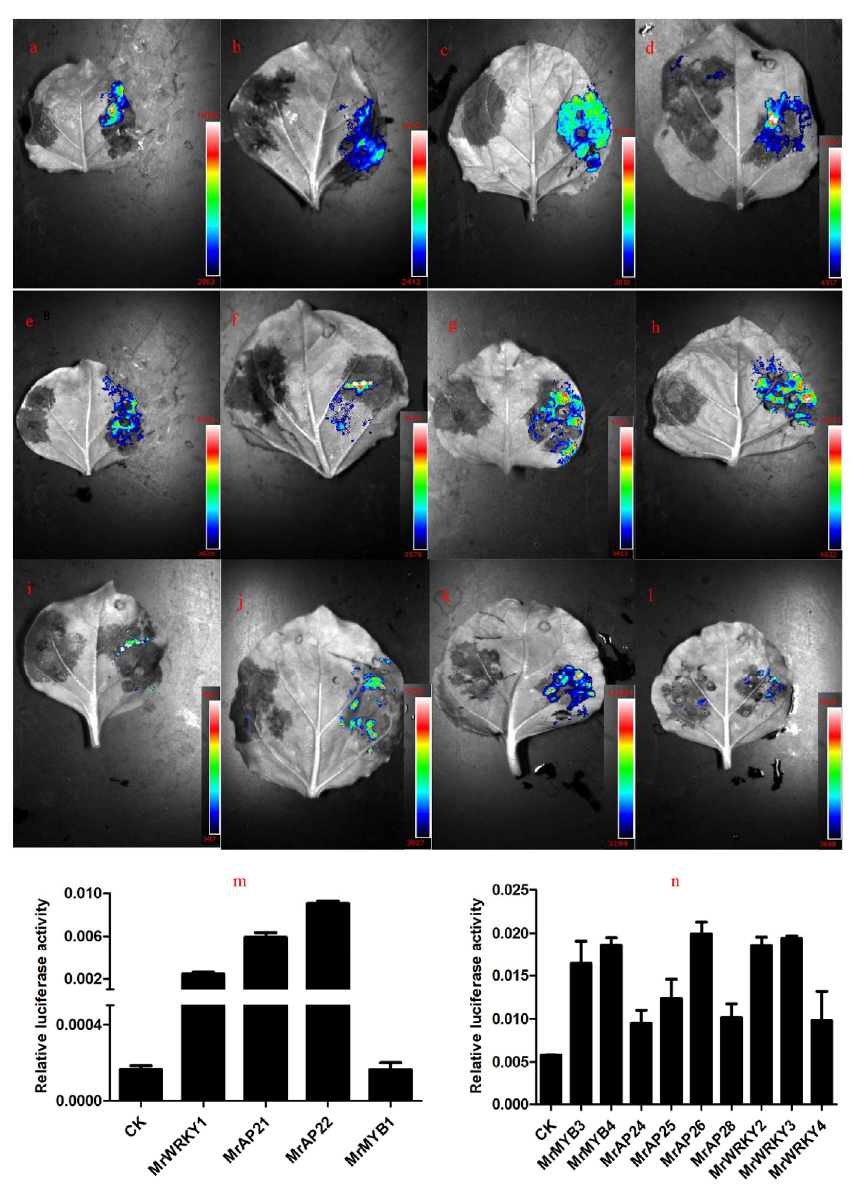
Figure 8. Dual-luciferase reporter analysis of MrFPS and MrBBS promoters and transcription Figure 8. Dual ‐ luciferase reporter analysis of MrFPS and MrBBS promoters and transcription fac ‐ tors. ( a – c ) Double luciferase activity of the MrFPS promoter with MrWRKY1 , MrAP21 , and MrAP22 . ( d – l ) Double luciferase activity of the MrBBS promoter with MrMYB3 , MrMYB4 ,